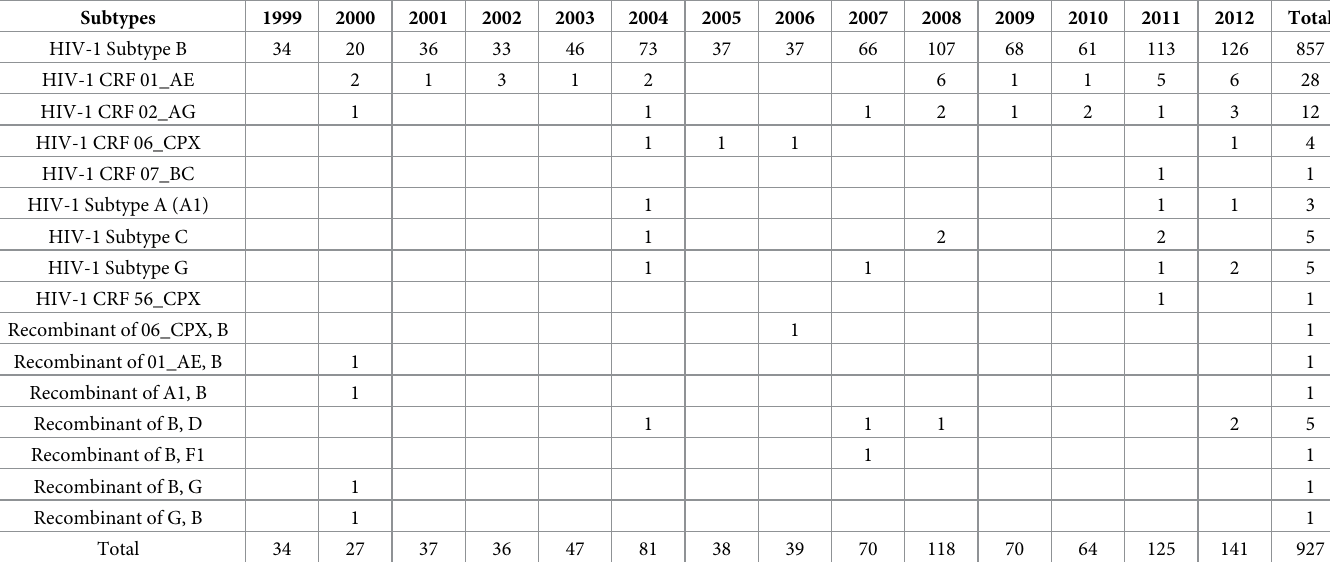
Table 2. Characteristics of the HIV-1 subtypes in Korea from 1999 to 2012.